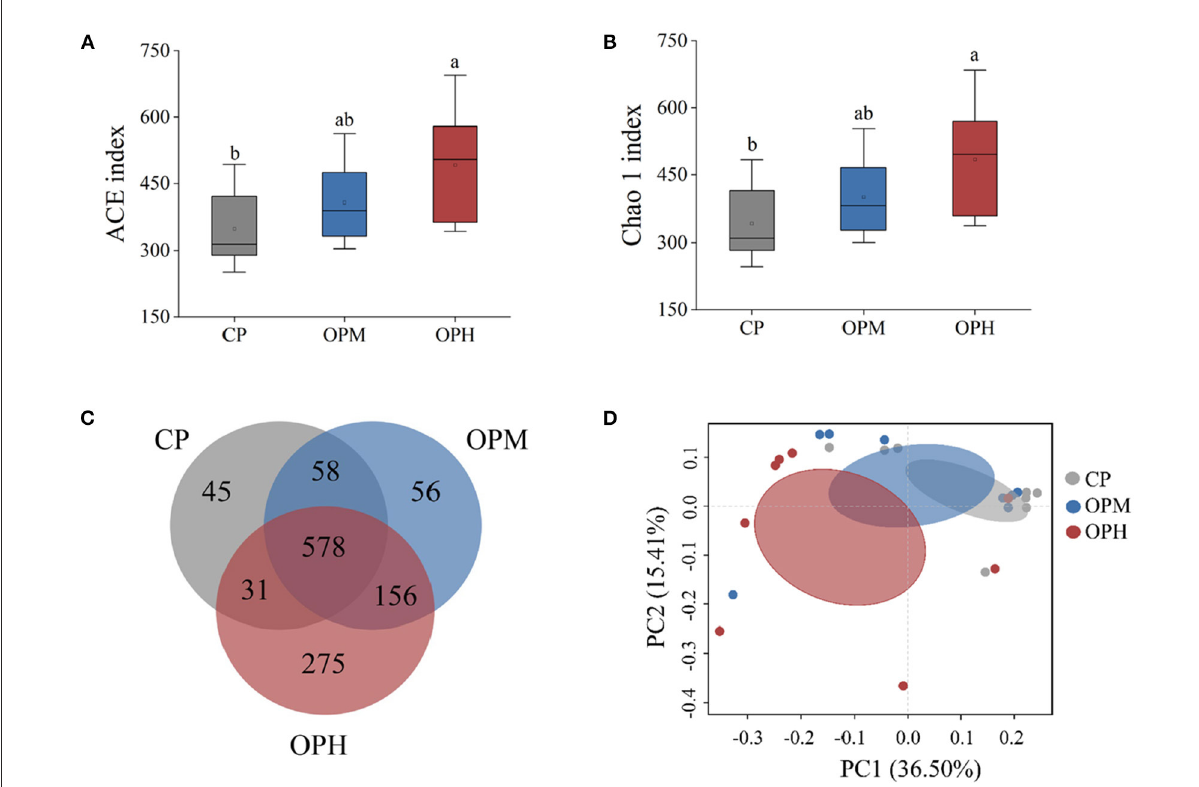
FIGURE2 Effects of consuming oxidized beef protein on α and β diversity of GM. (A) ACE index; (B) Chao1 index; (C) PCoA based unweighted unifrac distances; (D) Venn diagrams of OTUs. Different letters (a,b) represent significant differences ( p < 0.05). The results of ACE index and Chao1 index were expressed in box plot with whisker bar ( n =